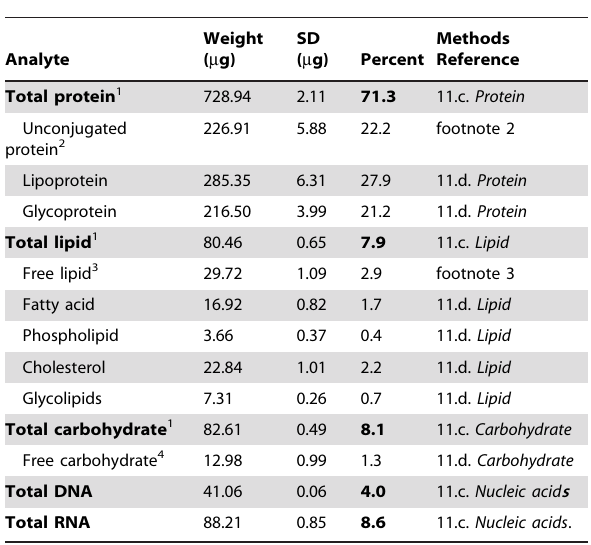
Figure 5. STEM, dark-field image of collapsed Spiroplasma vesicles on a thin carbon film. [A] Completely collapsed, flat vesicles are marked (V). Only uniform areas of these vesicles were used for mass-per-area measurements. Many small, tightly aggregated vesicles are scattered on the carbon film. TMV particles (T) were used as mass standards. Scale bar=100 nm. Inset: Vitrified membrane vesicles and a vitrified cell, suspended over a hole in a carbon film, are shown for comparison with the freeze-dried specimen . Scale bar=0.4 m m.